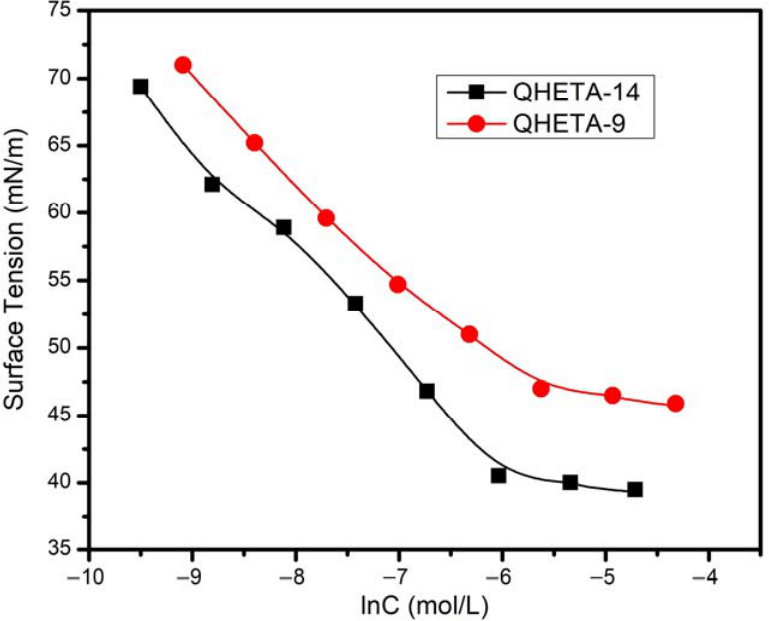
Figure 1. Surface tension of QHETA-14 and QHETA-9 in aqueous solution at 25 ◦ C. Table 1. Surface activity properties, cmc, RSN and zeta potentials of QHETA-9 and QHETA-14 The cmc (mol. L − 1 ) and ST ( γ cac ; mN.m − 1 ) data of QHETA-14 and QHETA-9 surfactants at 25 ◦